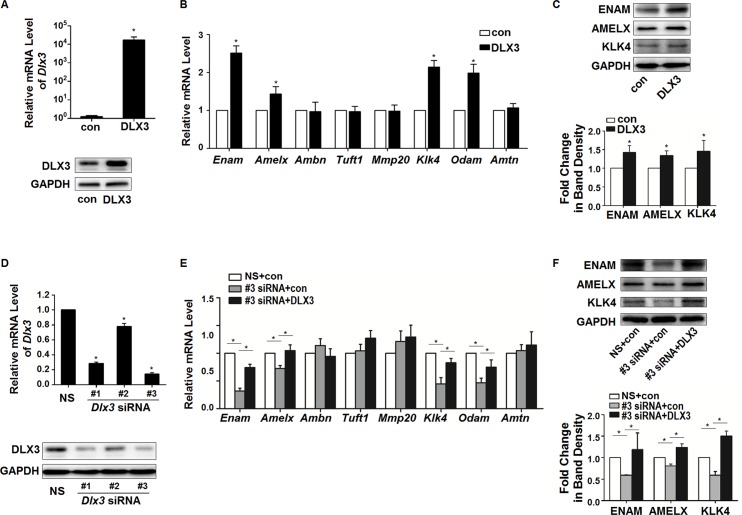
Regulation of Enam, Amelx, Klk4, and Odam by DLX3-overexpression and knockdown.(A) Over-expression of DLX3 was determined by real-time RT-PCR and western blot. Values are mean ± SD of the data from three independent experiments. *P <0.05 vs. control (con) group. (B) After 36 h of transfection, the expression of EMP genes was assessed. The mRNA expression of Enam, Amelx, Klk4, and Odam were significantly up-regulated. Values are presented as mean ± SD. *P <0.05 vs. the control (con) group. (C) After 48 h of transfection, elevated protein expression of ENAM, AMELX, and KLK4 were detected by western blot. Upper panel: western blot bands of ENAM, AMELX, and KLK4 (representative of three independent experiments). Lower panel: densitometric analysis of images of 3 independent experiments. *P <0.05 vs. the control (con) group. (D) Expression levels of DLX3 were determined after transfection with 3 independent Dlx3-specific small interfering RNAs (Dlx3 siRNA #1, #2, #3), or a nonspecific siRNA, NS siRNA. Values are from three independent experiments, and shown as mean ± SD. *P <0.05 vs. NS group. (E) After DLX3 silencing (using Dlx3 siRNA #3), the expression of EMP genes was assessed. The expression of Enam, Amelx, Klk4, and Odam was significantly down-regulated, and then successfully rescued by transfection of plasmid pCI-neo-V5DLX3WT. Values are mean ± SD of data from three independent experiments. *P <0.05. (F) At the protein level, expression of ENAM, AMELX, and KLK4 were also down-regulated by DLX3-knockdown and then rescued by pCI-neo-V5DLX3WT transfection, as analyzed by western blot. Upper panel: western blot bands of ENAM, AMELX, and KLK4 (representative of three independent experiments). Lower panel: densitometric analysis of images of 3 independent experiments. *P <0.05.